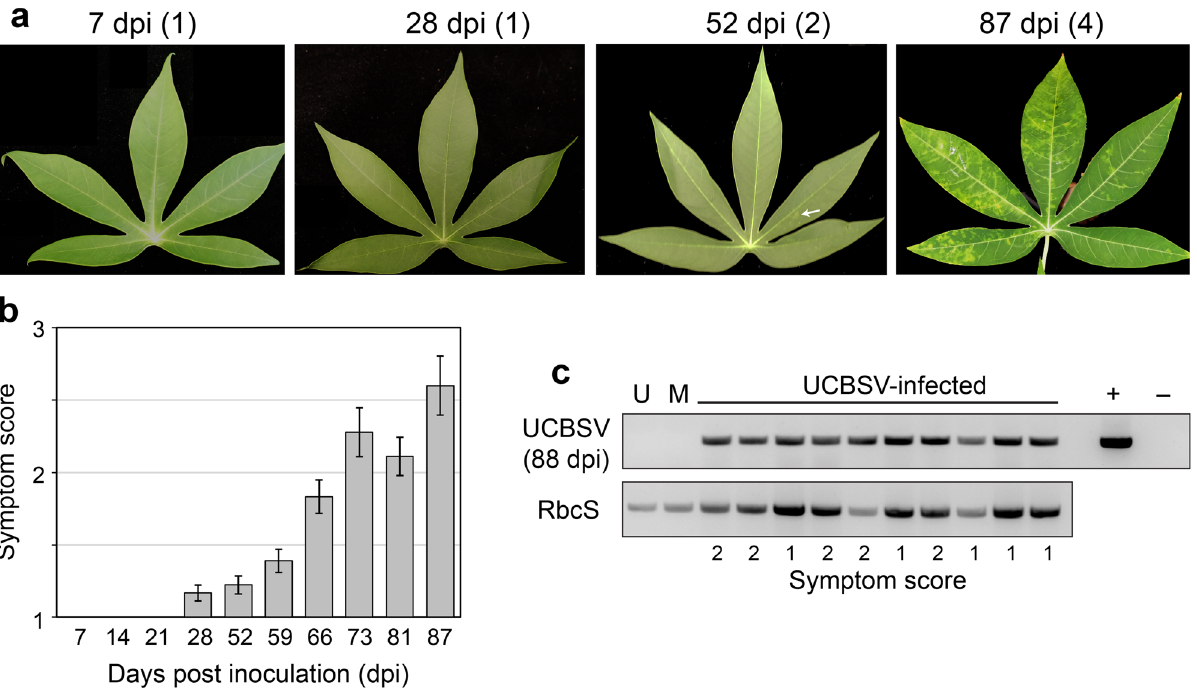
Figure 1. Infection results for Trial 2. ( a ) Images of leaves from TME204 plants at 7, 28, 52 and 87 dpi. The symptom score of each leaf is in parentheses. The white arrow points to faint yellow blotches characteristic of a symptom score of 2. ( b ) Average symptom scores from 7 to 87 days. ( c ) End-point RT-PCR of total RNA extracts isolated from untreated (U), mock-inoculated (M), and UCBSV-inoculated plants at 88 dpi. The upper panel shows a 445-bp band corresponding to UCBSV. The lower panel shows a 619-bp band corresponding to a cassava RbcS transcript, which served as a positive control for the isolation of amplifiable RNA.